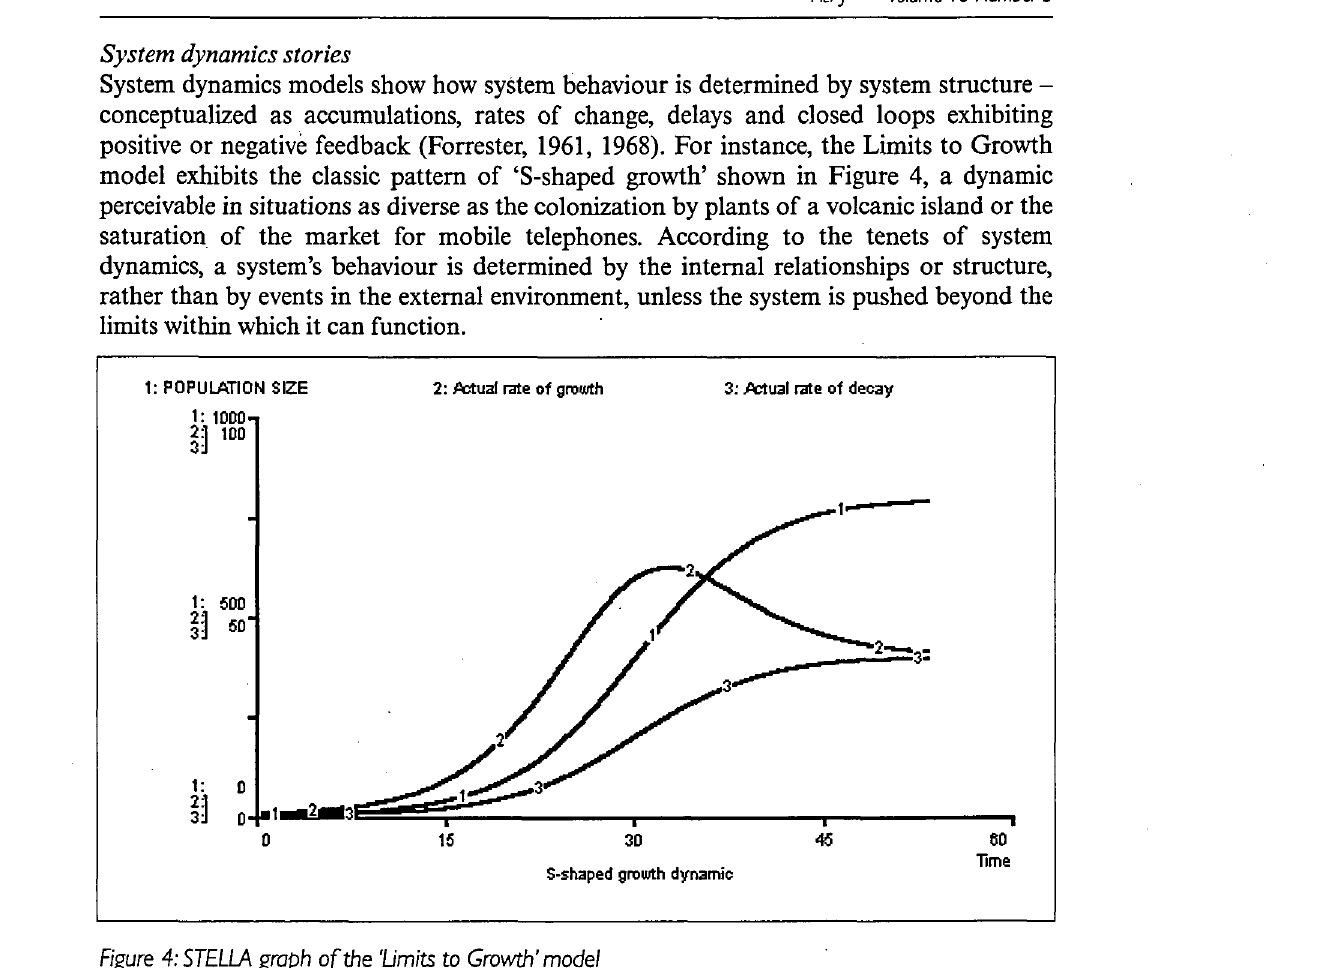
Figure 4: STELLA graph of the 'Limits to Growth'